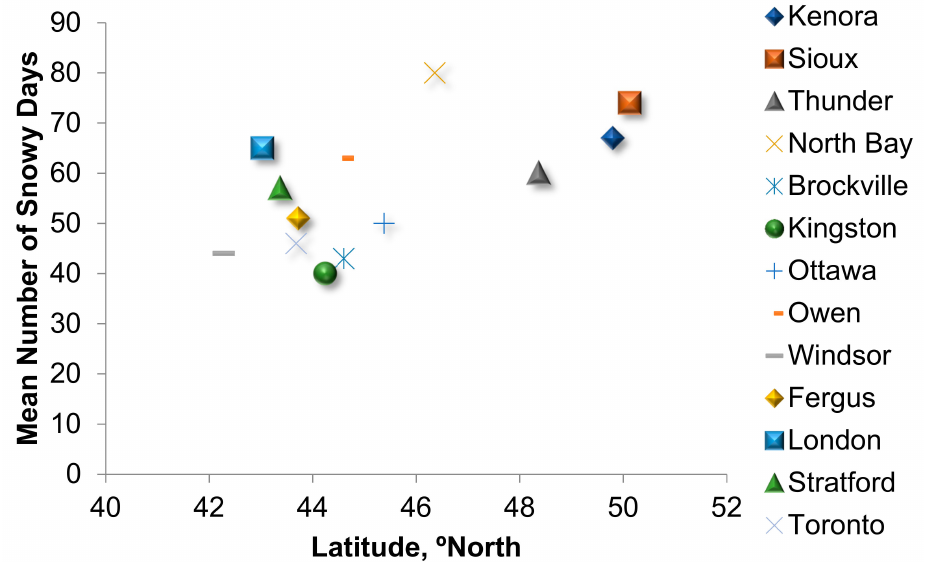
Figure 5. The variation in number of snowy days with